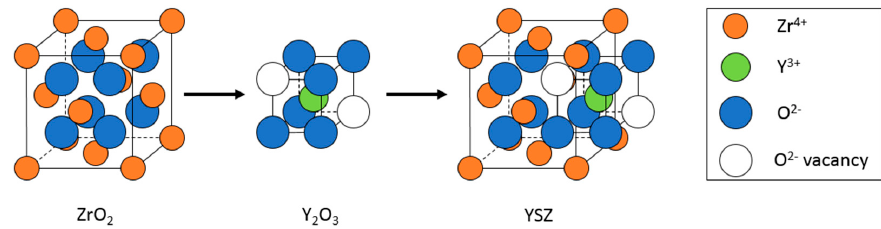
Figure 4. Cubic structure of yttria-stabilized zirconia (YSZ).